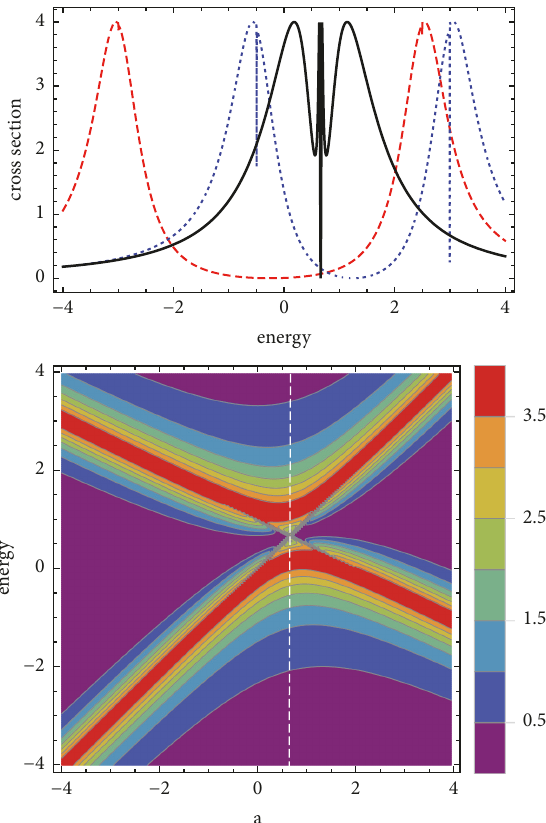
Figure 3: The same as Figure 2 but with 𝜔 (1) ̸= 𝜔 (2) . The parameters are the same as in Figure 1,